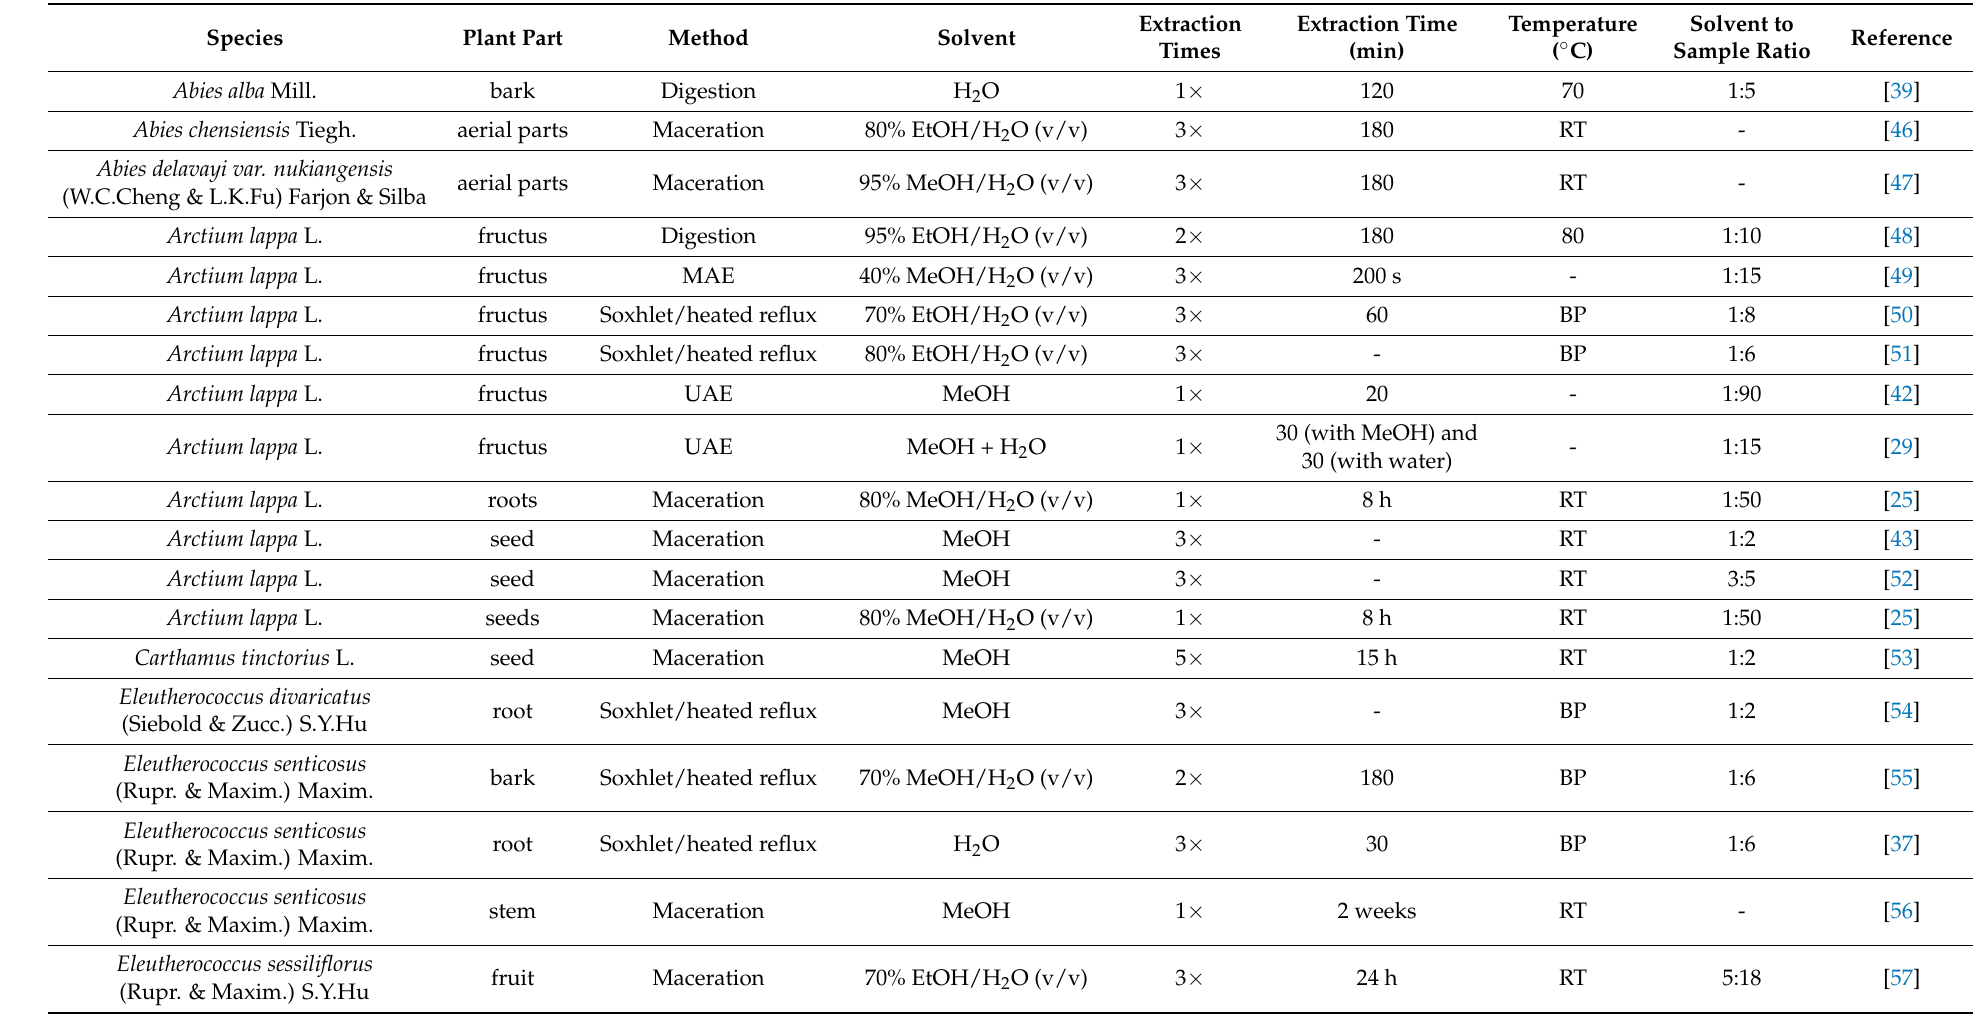
Table 1. Comparison of methods used in lignans’